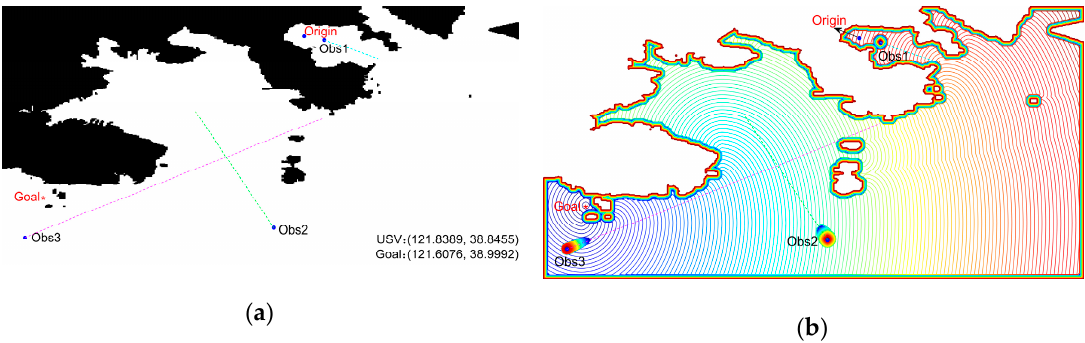
Figure 27. Simulation cycle 1, namely, the initial state: ( a ) task and location information; ( b ) the corresponding potential field.